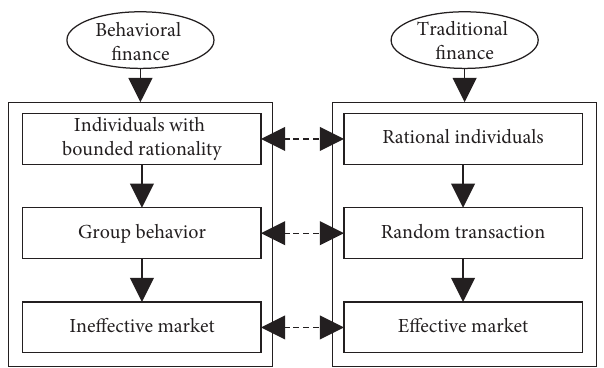
Figure 2: Differences between traditional finance and behavioral